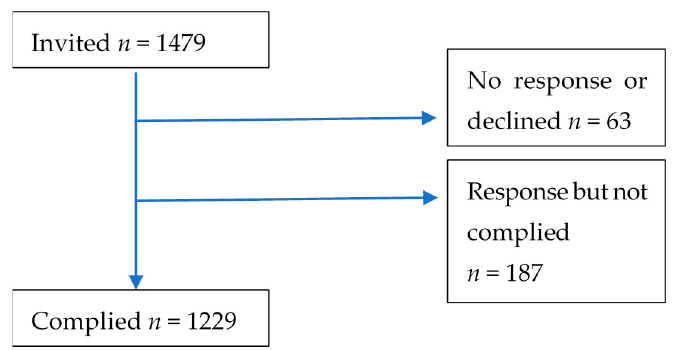
Figure 1. Recruitment process.